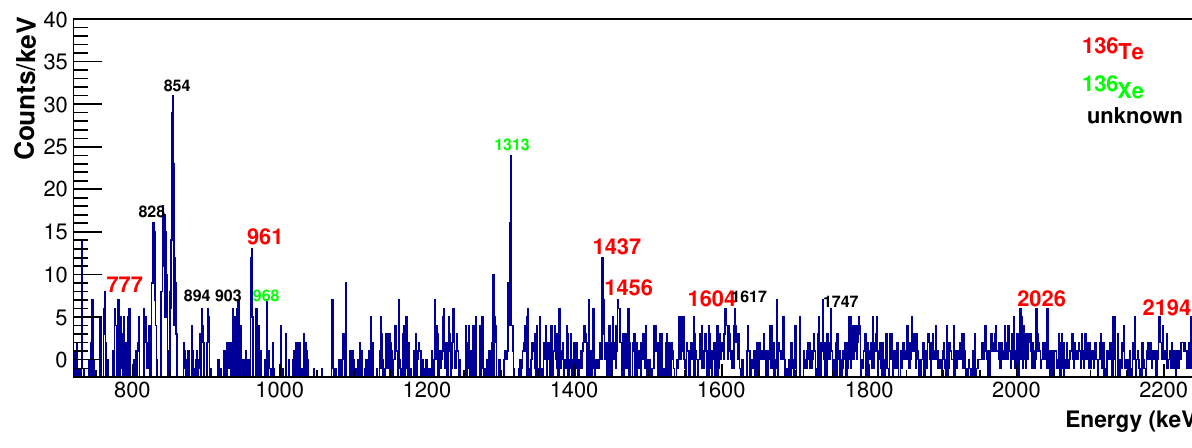
→ 0 + transition 1 → 0 + in 136 Xe (green). New transitions e.g. 1